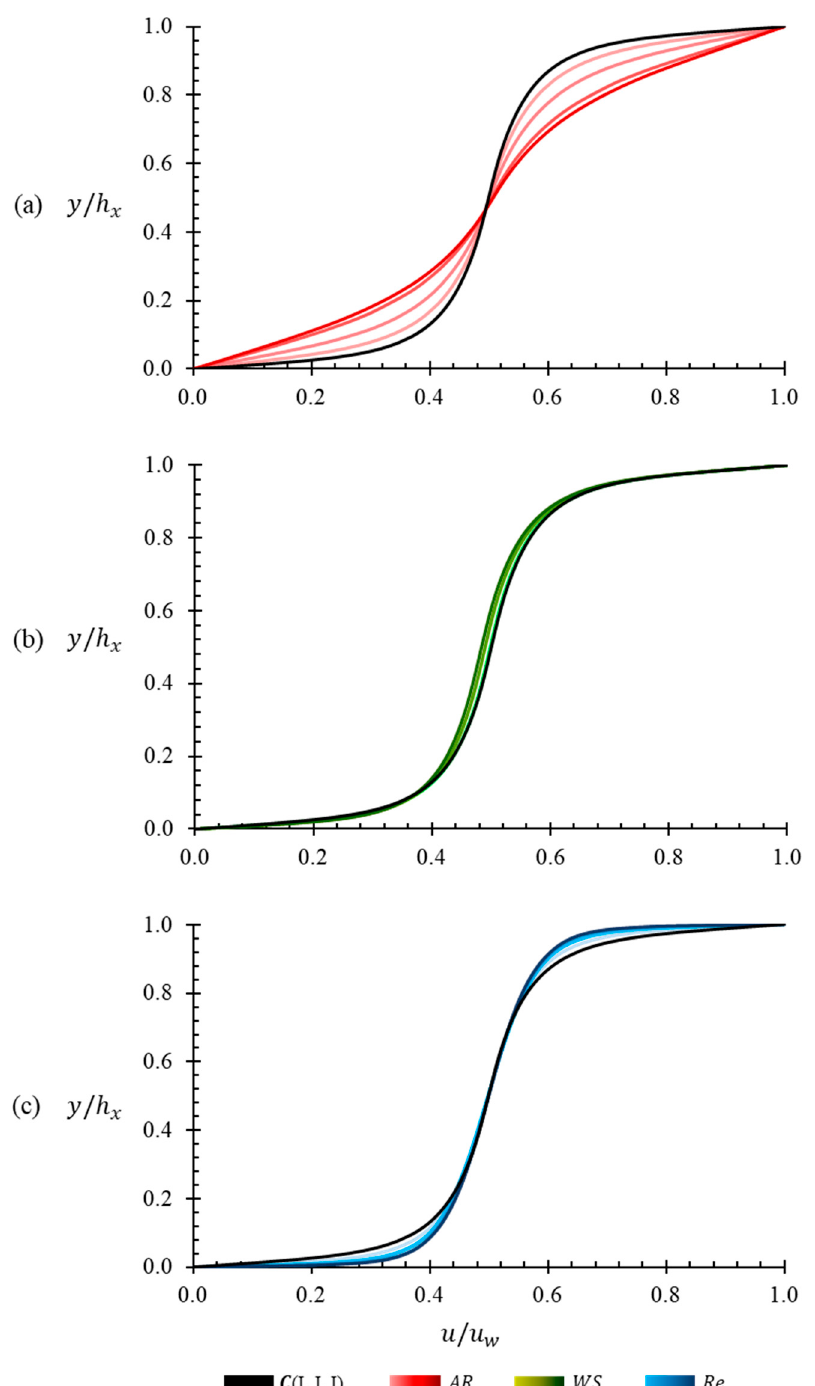
Figure 9. Influence of parameters on mean velocity profiles: ( a ) AR , ( b ) WS and ( c ) Re . Data plotted for streamwise location, x λ = 0, indicative for all other streamwise locations.